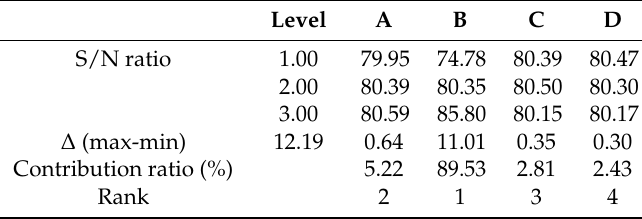
Table 12. Response table for Q